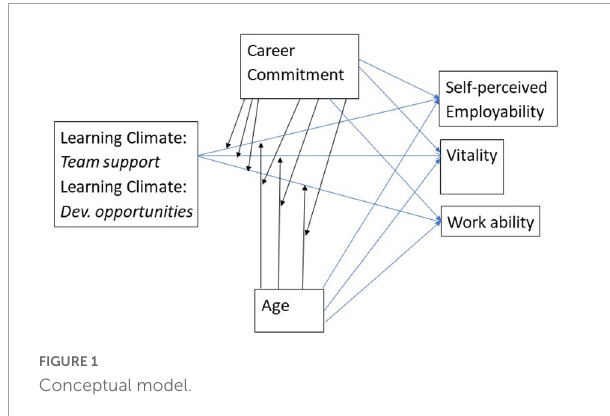
FIGURE1 Conceptual